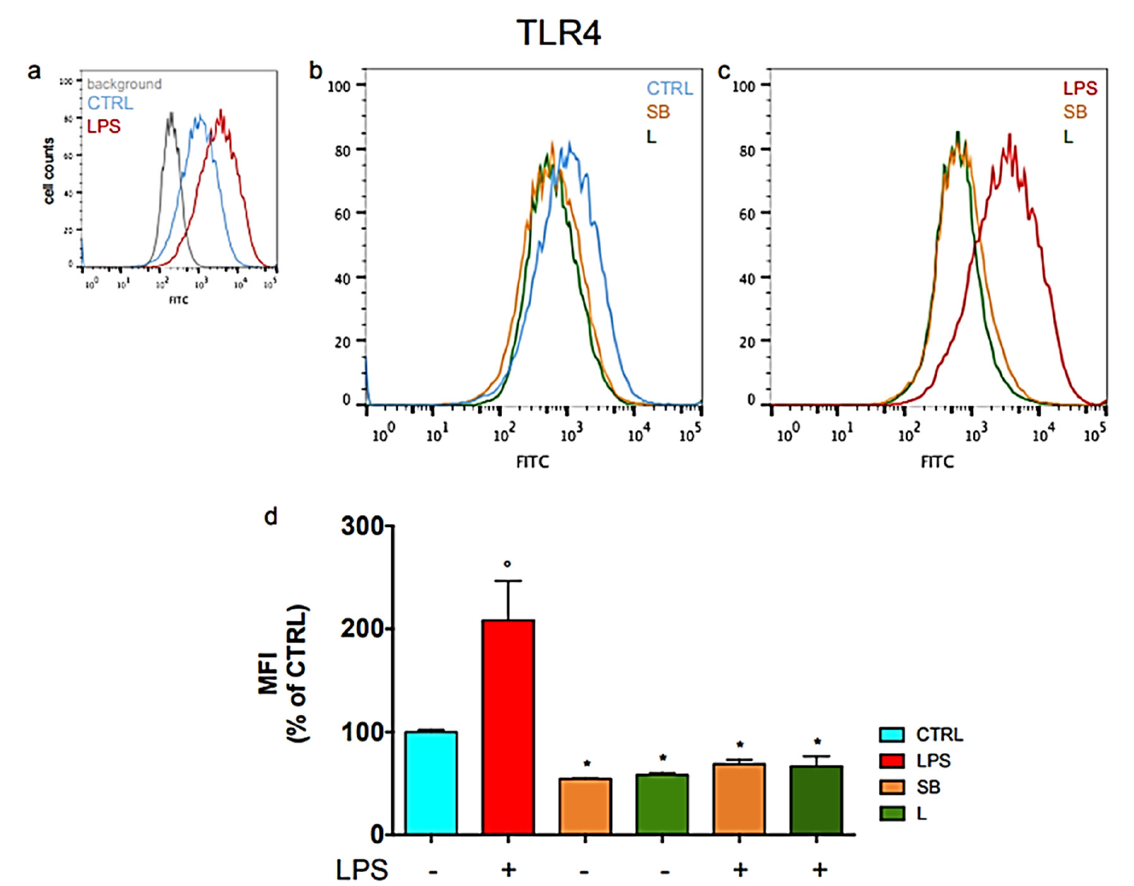
Figure 2. Cell surface level of TLR4 in BV-2 cells treated with chestnut leaf or spiny bur extracts and LPS. BV-2 cells were pre-treated (or not) with spiny bur (SB) or leaf (L) extracts (0.5 mg/mL) for 3 h, incubated with or without LPS (0.5 μ g/mL) for a total of 24 h, then subjected to flow cytometric analysis of the immunostaining for TLR4 receptor. ( a ) Representative plots of untreated BV-2 cells ( b ) Representative plots of BV-2 cells not activated with LPS ( c ) Representative plots of LPS-stimulated BV-2 cells ( d ) Relative quantification is expressed as MFI, median fluorescence intensity. Results are expressed as means ± SEM of three independent experiments. Statistical analysis was performed by Fisher’s LSD test following one-way ANOVA. ◦ p < 0.05 significantly different from control cells; * p < 0.05 significantly different from LPS-treated cells.